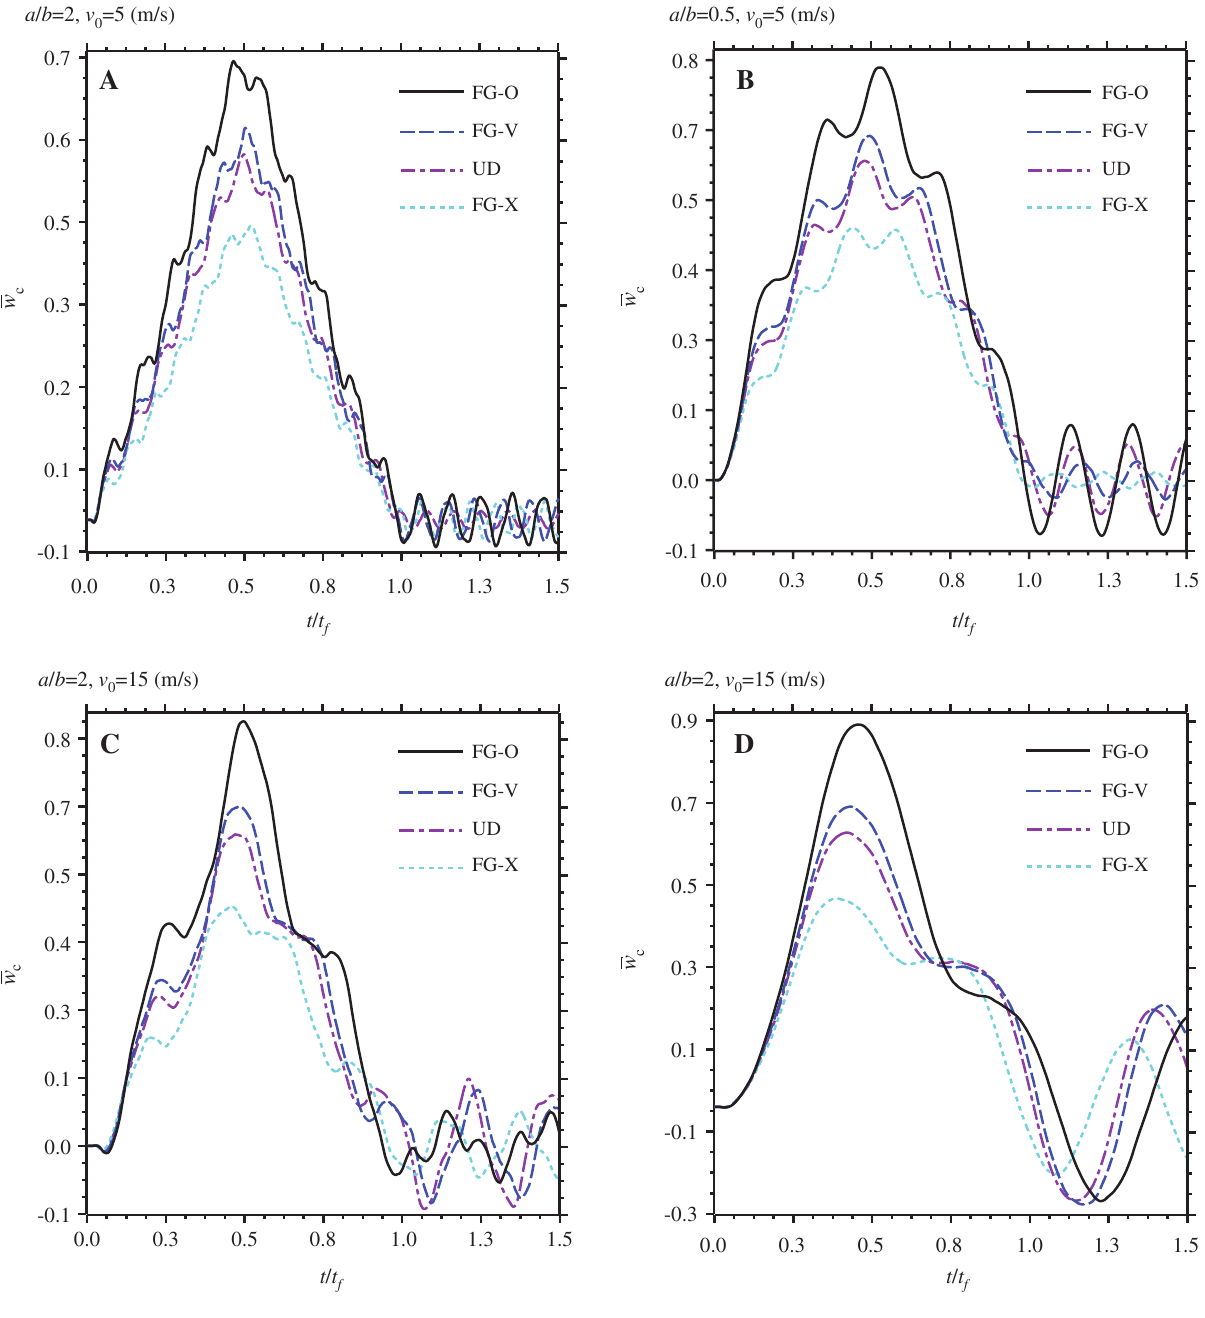
Figure 8 (A–D) The influence of three different CNT distributions on the time history of the nondimensional center deflection simply sup- ported (SSSS) FG